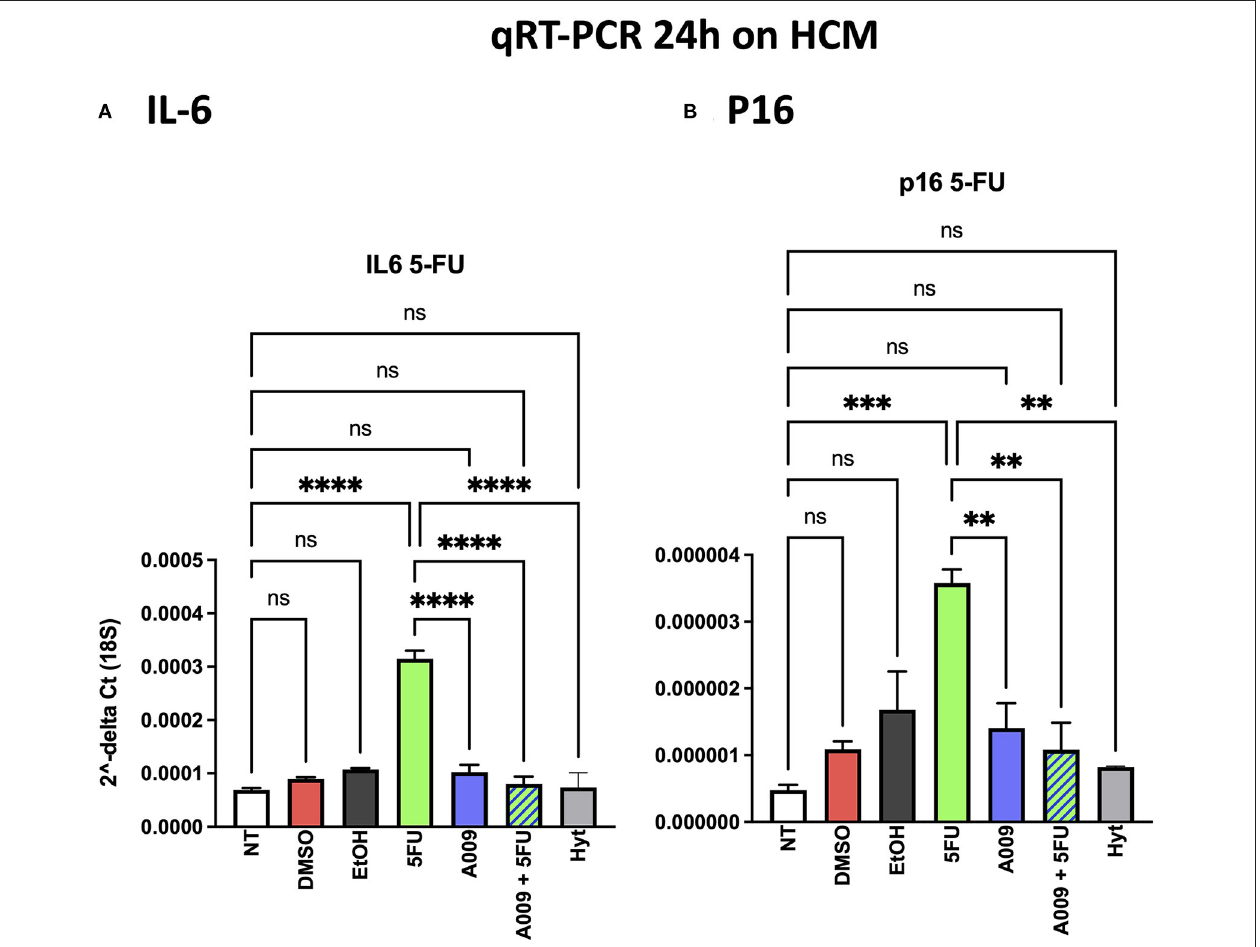
FIGURE 8 | Effects of the A009 extract on interleukin (IL)-6 and p16 expression in human cardiac myocytes by qPCR. The ability of A009 (dilution 1:800) to inhibit (A) IL-6 and (B) p16 expression in HCM was determined, following 24h of stimulation, by qPCR. Data are shown as mRNA relative expression, normalized to 18S and control, mean SEM, one-way ANOVA, ** p < 0.01, *** p < 0.001, and **** p < 0.0001. A009 combinations with chemotherapy reduced IL6 and p16 ±